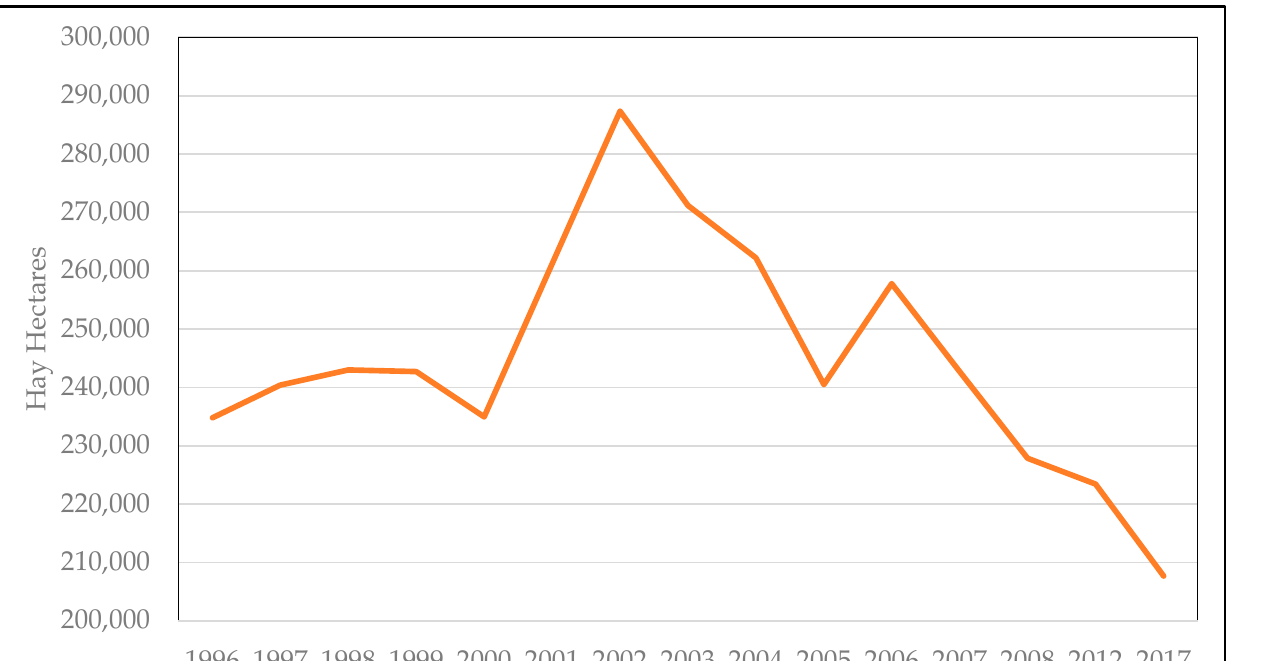
Figure 11. Harvested Hay Hectares for the 22 counties in the study since 1996.